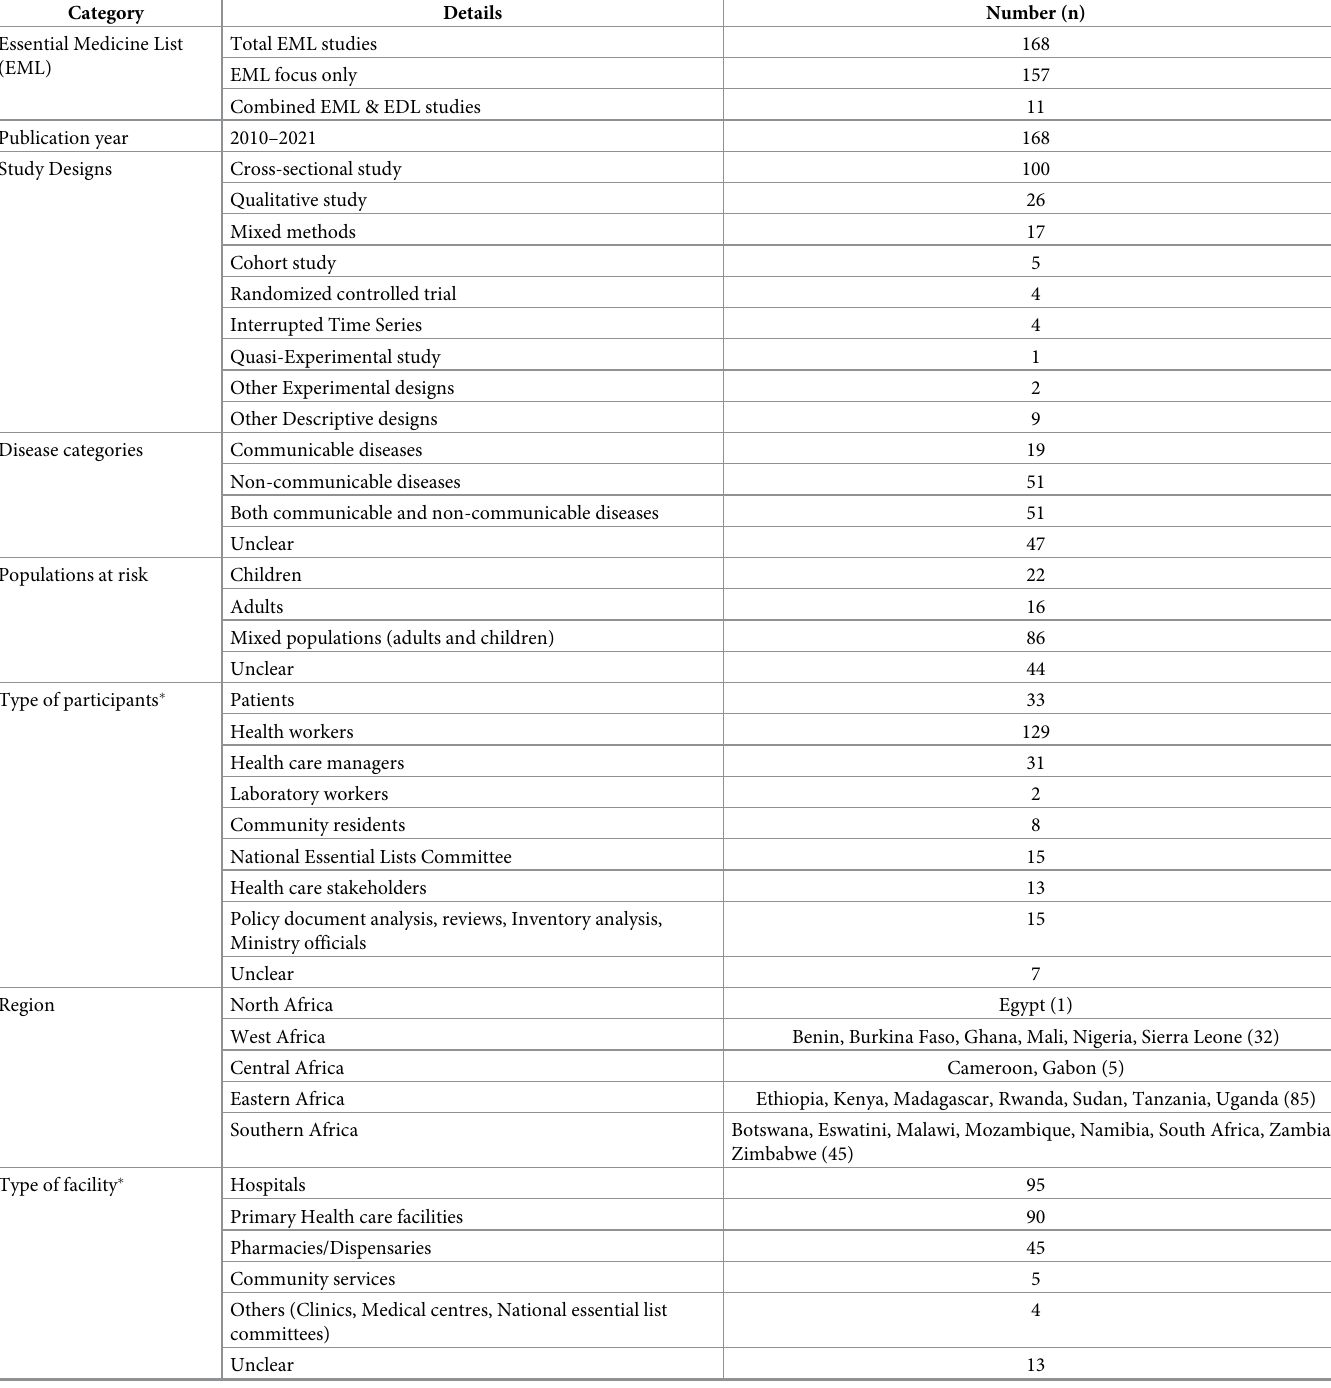
Table 2. Characteristics of studies about the Essential Medicine List (EML).